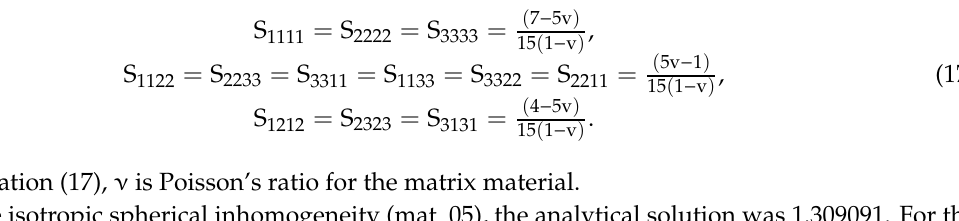
Figure 13. A typical discretized spherical model in the volume integral equation method (VIEM). ( a ) A spherical model; ( b ) an inside view of a spherical model. Table 5. Material properties of the isotropic matrix and the isotropic spherical inhomogeneity.